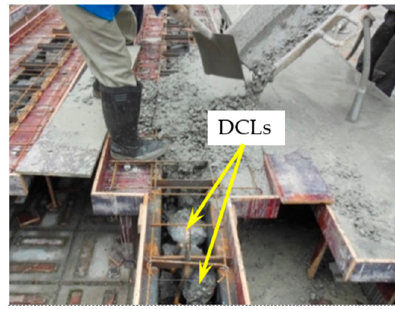
Figure 4. Concrete casting of a specimen containing DCLs and FC.